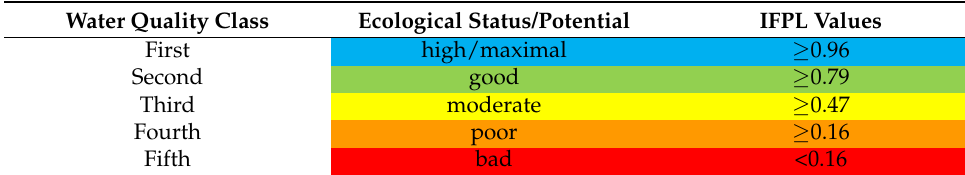
Table 1. Limit values for the Great Lowland River water quality classes according to phytoplankton surveys (multimetric phytoplankton index for rivers—IFPL).